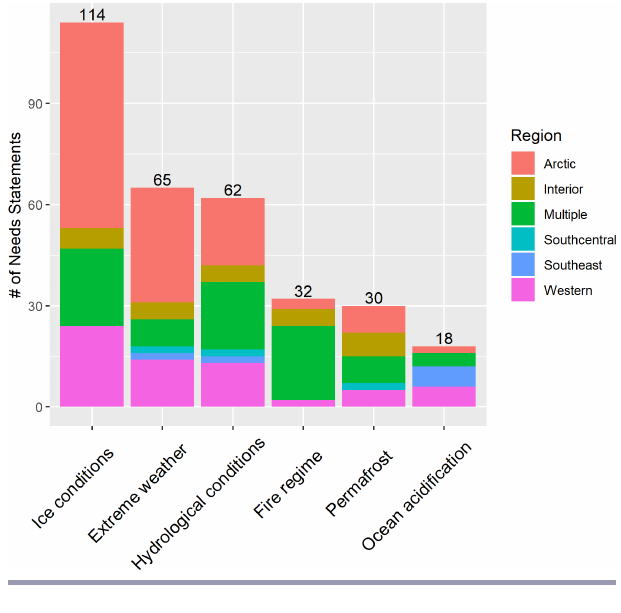
Fig. 4 . Stakeholder information needs related to biophysical environmental conditions that affect wild food harvest (2008– 2018).